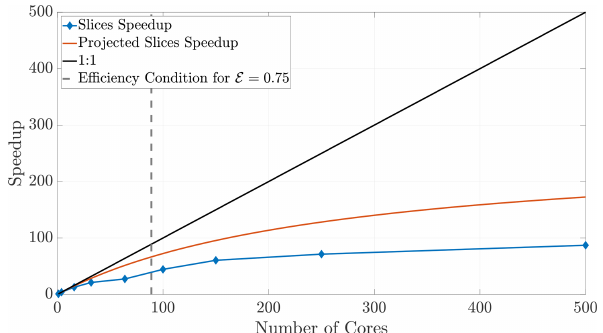
Figure 14. Speedup for the slices method plateaus quickly, as the ghost regions increase in proportion to the local subdomain’s area.